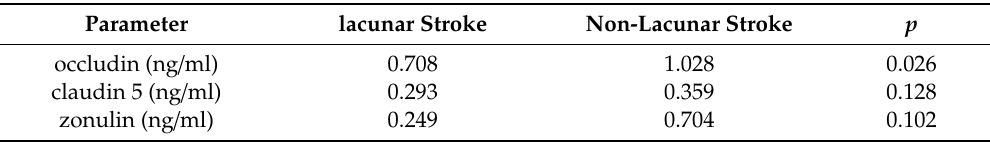
Figure 3. The comparison of the mean concentration of ZO-1 between patients with- and without arterial hypertension. Table 3. The mean concentrations of occludin, claudin 5, and ZO-1 associated with lacunar vs. non-lacunar